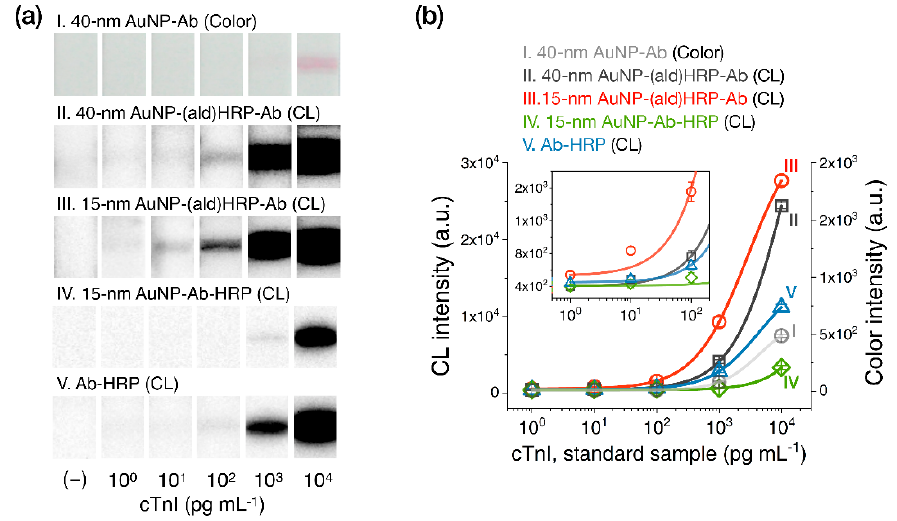
Figure 5. Results of cardiac troponin I (cTnI) standard sample testing with the LFA. ( a ) Test line images. ( b ) Test line intensity plot. All data shown in ( b ) represent the mean ± SD (n = 3). The cTnI levels shown reflect the final concentrations used in the assays.